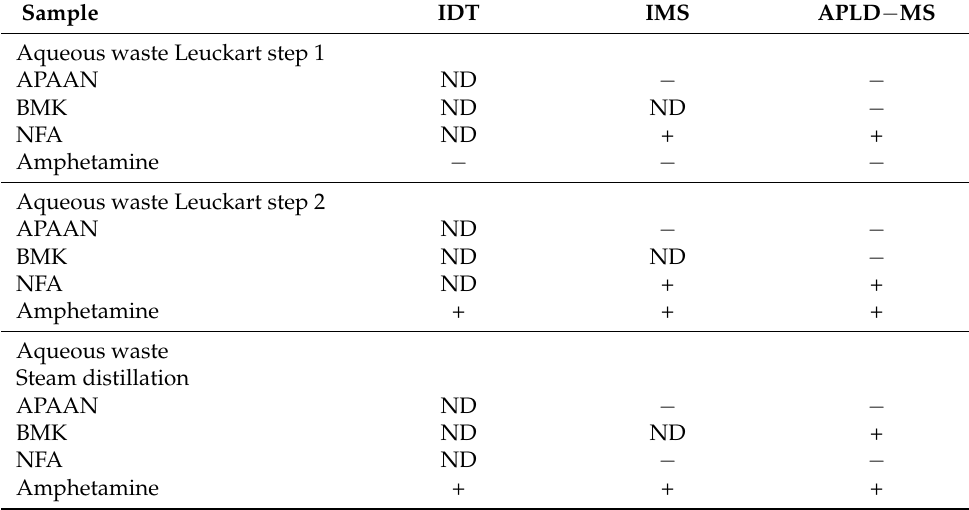
Table 3. Sampling swabs applied at different glassware of an amphetamine. ND mean technically not detectable, plus means positive detection and minus means negative detection. All samples were measured once, due to limited